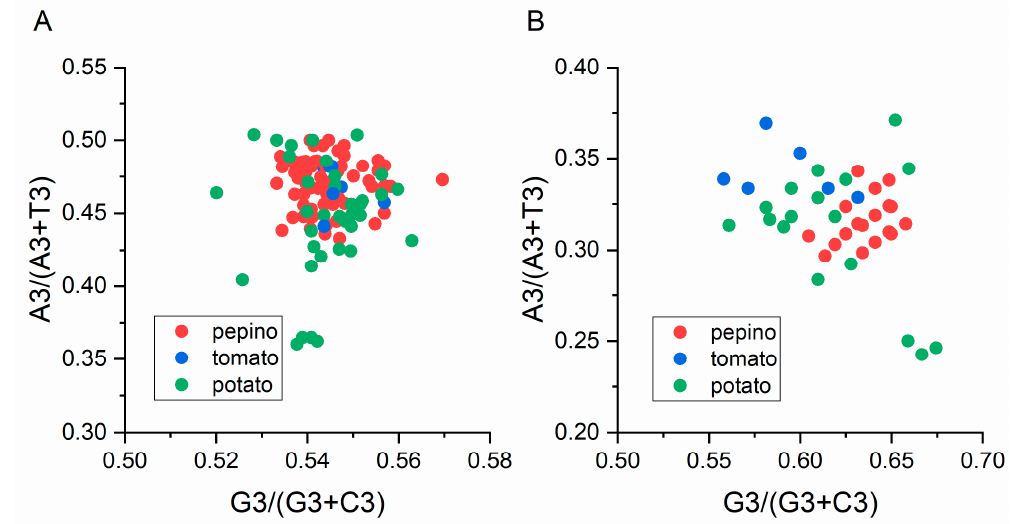
Figure 6. The AT [A3% / (A3% + T3%)] and GC [G3% / (G3% + C3%)] bias of the CP ( A ) and NABP ( B ) genes of PVM are shown. The center of the plot (both the coordinates is 0.5), indicating a position where there is no bias. The pepino, potato and tomato hosts are represented by red, green and blue dots, respectively.